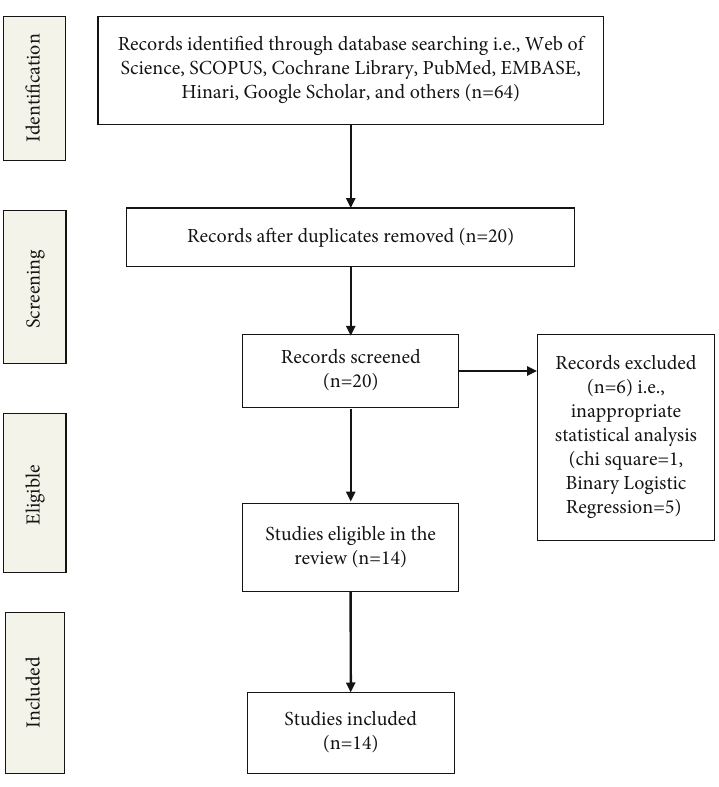
Figure 1: Flow diagram of the review